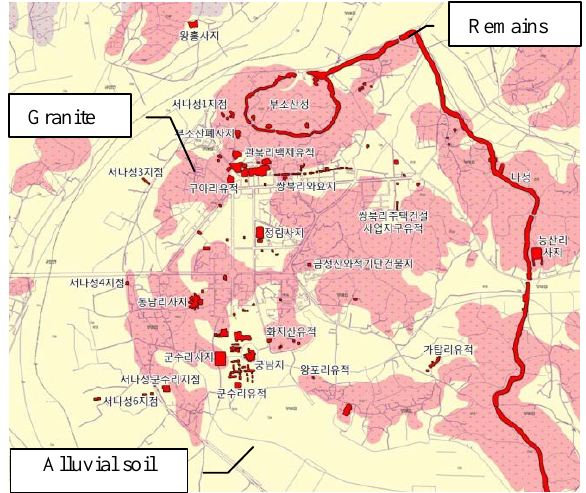
Figure 2. Geographical feature and remains